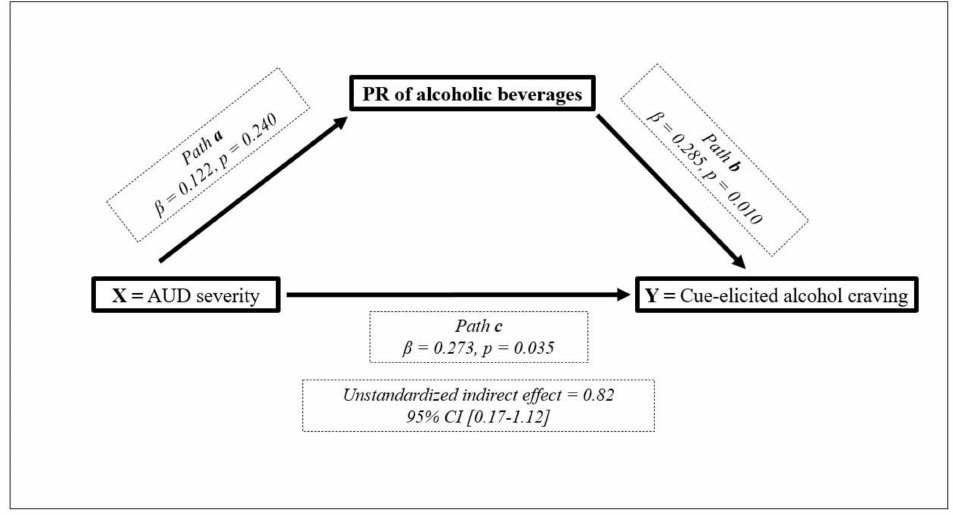
Figure 3. Mediational